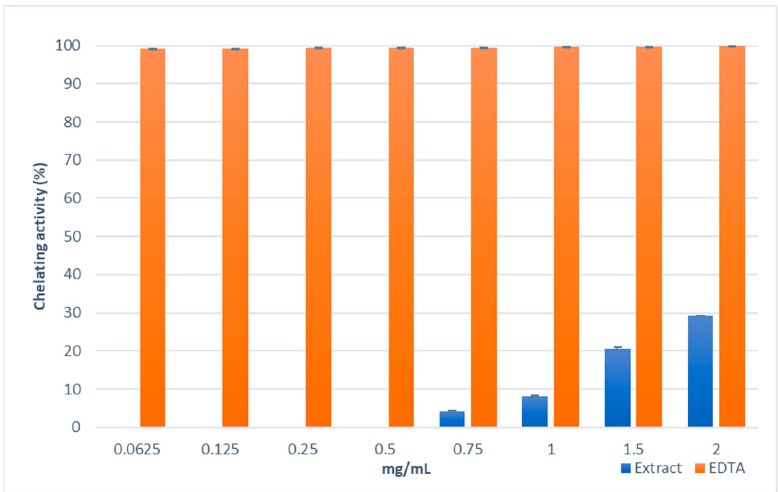
Figure 4. The chelating activity of the methanol extract obtained from the biomass of the in vitro shoot culture of Scutellaria brevibracteata subsp. subvelutina (3.0 mg/L BAP and 1.0 mg/L NAA). Measured by inhibition of the ferrozine–Fe 2+ complex formation. Values are expressed as the mean ± SD ( n = 3).